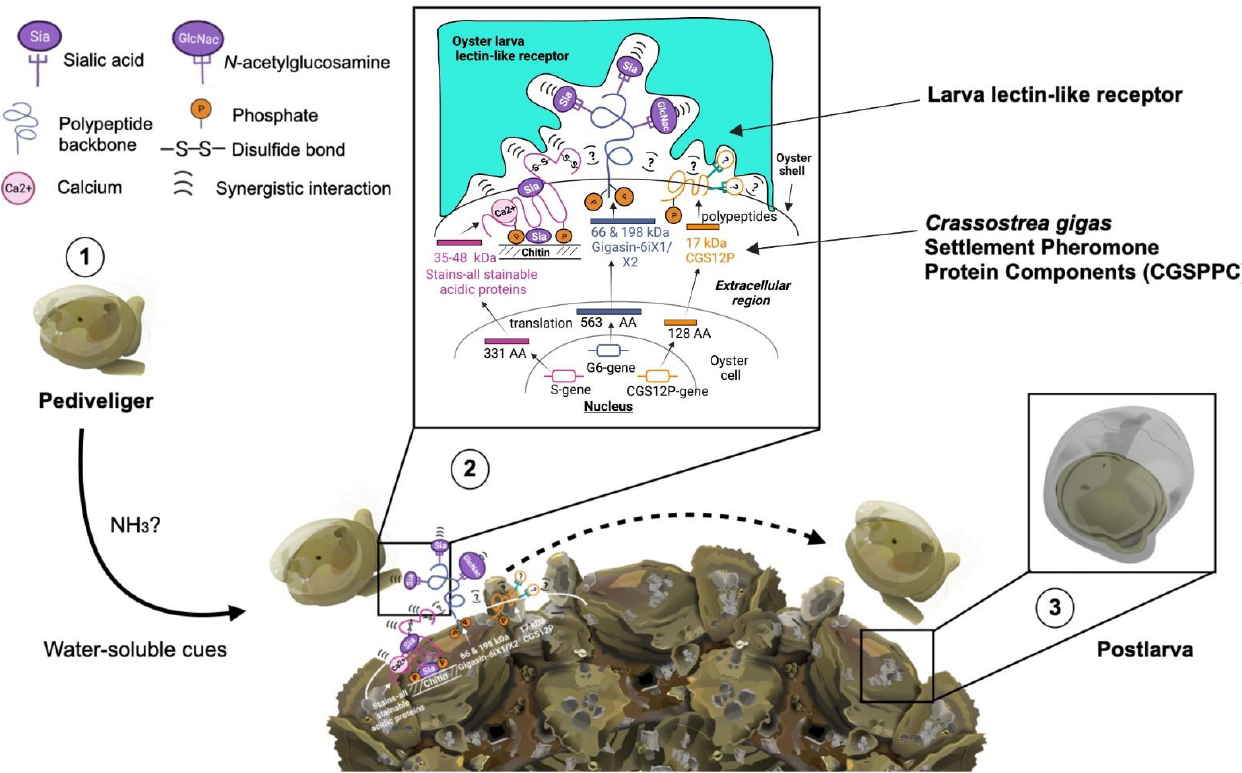
Figure 7. Schematic of the Crassostrea gigas Settlement Pheromone Protein Components (CGSPPC)- mediated larval settlement-induction mechanism. ( 1 ) As the oyster larva becomes a competent pediveliger, with a fully developed eye and foot, it begins to exhibit searching behaviors. This searching behavior is influenced by the detection of water-soluble cues from metabolites, including glycans, NH 3, and other amino acids, from bacteria or their conspecifics. ( 2 ) By locating the source of the inducing cue, the larva recognizes the amino acid groups, glycan moieties, and phosphate groups on the surface-bound cue, CGSPPC, that are found on shells of conspecific postlarvae and adult oysters. The noncovalent bond interaction between the lectin–glycan and/or phosphate groups in both the larva and substrate cue, i.e., shells of conspecifics, allows accumulation of transduced cues and creates a seemingly complex recognition system in C. gigas . This allows higher affinity, specificity, and complementarity between CGSPPC and its receptor to ensure greater selectivity during site selection. ( 3 ) Having accumulated enough signals from a suitable settlement site, a cascade of biochemical changes is triggered that leads to the attachment and its eventual metamorphosis into a postlarva. The postlarva develops newly formed gills and a new layer of an adult shell while its eye, foot, and velum disappear. This figure was partly created using BioRender.com (accessed on 25 July